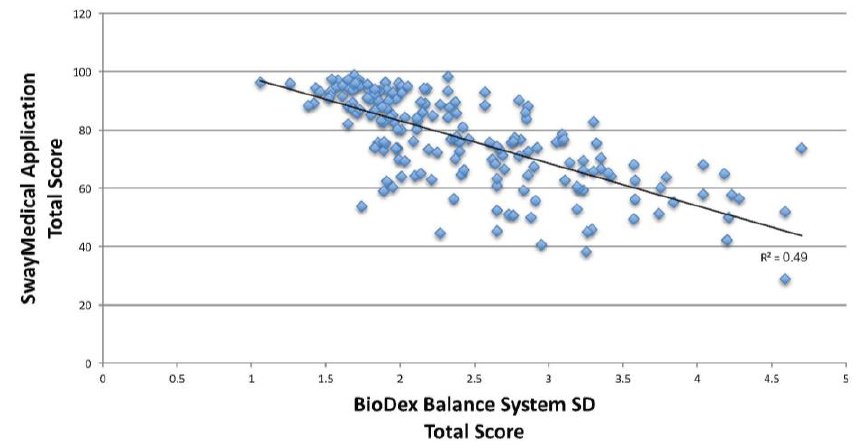
Figure 2. Pearson’s r correlation, comparing the relationship during the Balance Error Scoring System overall scores between the BioDex Balance System SD and the Sway Medical Application. The overall score incorporating all five stance conditions showed a significant, high, and negative correlation ( p < 0.001, r = − 0.70).